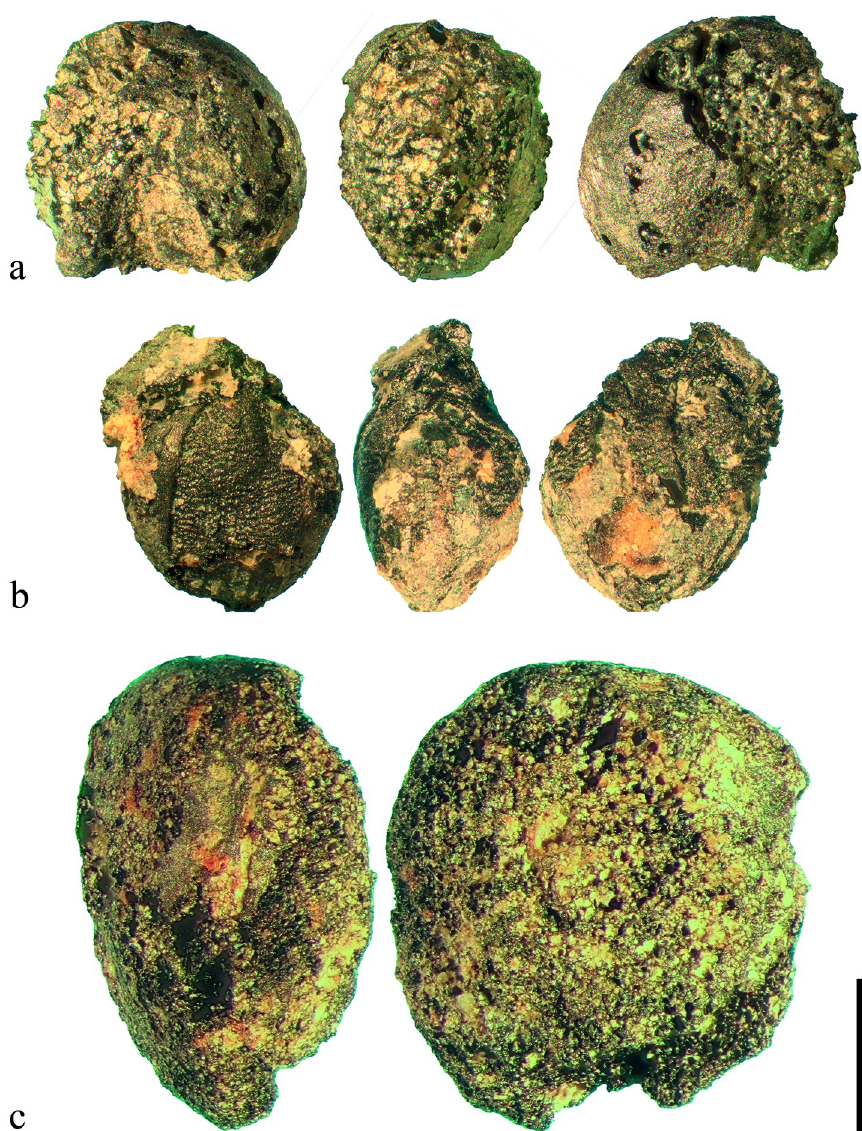
Fig 12. Charred finds of the most important cultivated crops from the Late Bronze Age layers at Prigglitz-Gasteil. a) broomcorn millet ( Panicum miliaceum ), b) foxtail millet ( Setaria italica ), c) lentil (cf. Lens culinaris ). Scale bar length: 1 mm. Images: OeAW-OeAI/S. Wiesinger (top and middle row), A. G. Heiss (bottom row).